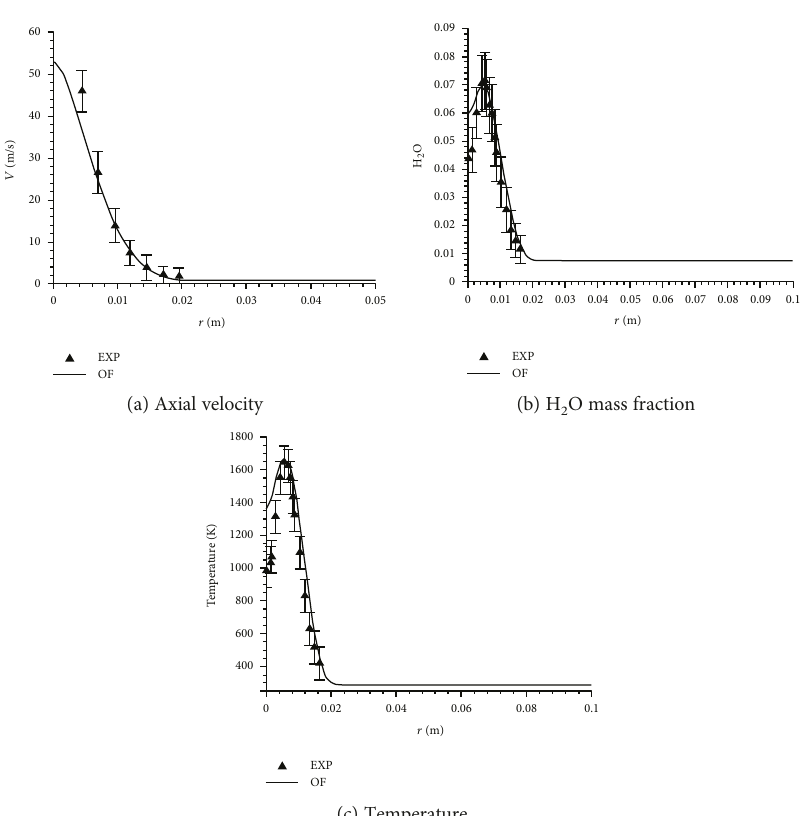
Figure 4: The radial pro fi le comparison of fl ame A at 20 jet